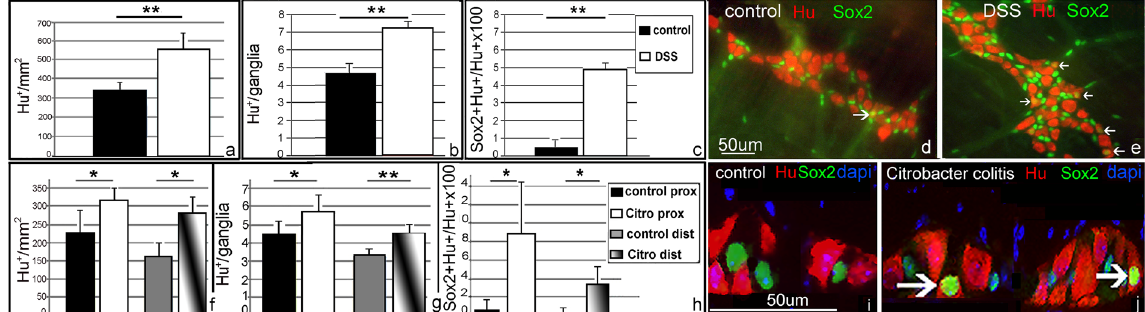
Figure 1. Chemical and infectious colitis both promote enteric neurogenesis. DSS colitis (n = 8) and Citrobacter rodentium colitis (n = 8) were induced in 4 month-old mice and the colons processed for immunohistochemistry using Hu antibody to label enteric neurons. Significantly more neurons are present throughout the colon in both DSS ( a , b ) and Citrobacter rodentium ( f , g ) models. This increased neuronal density is associated with an increase in the proportion of Hu + neurons that label with Sox2 (c-e and h-j, arrows point to Hu + Sox2 + neurons in ( d , e and j ). * p < 0.05, ** p < 0.01. ( d and e ) were taken at 200x, ( i and j ) at